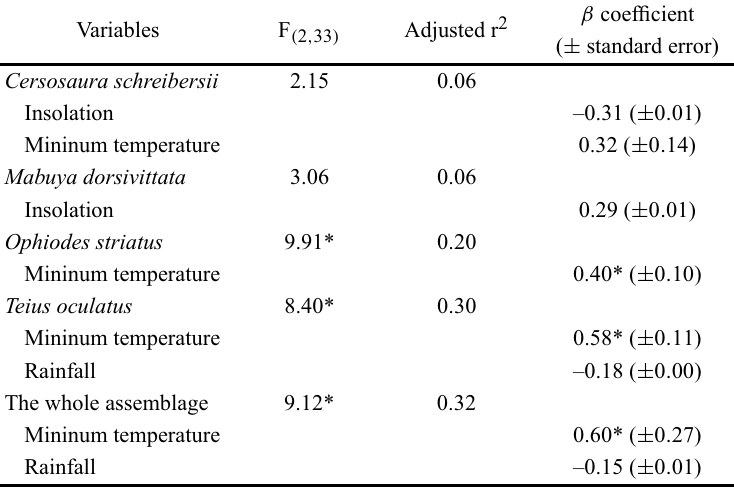
Multiple linear regression analysis for incidence of lizards captures and monthly climatic variables monitored in Pampean area, Rio Grande do Sul State, southern Brazil. (*) indicates statistical significance at